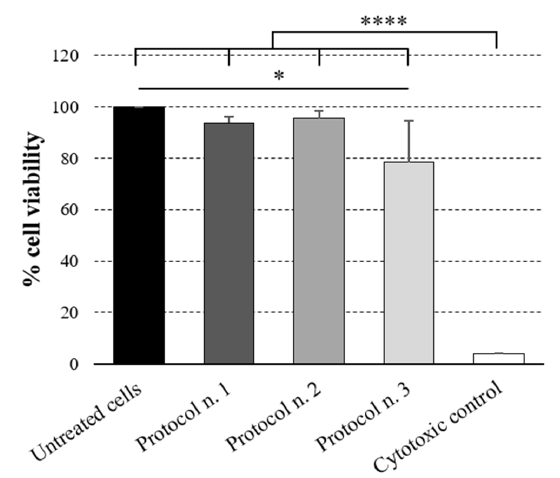
Figure 8. Cytocompatibility study. Cytotoxicity test on HM1 ‐ SV40 cell line incubated for 72 h with culture media conditioned with esophageal matrices decellularized through Protocols Nos. 1, 2 and 3. For each experimental group, the percentage of cell viability after the incubation period was de ‐ fined in comparison with the untreated cell cultures (100% viability) (* p < 0.05; **** p <